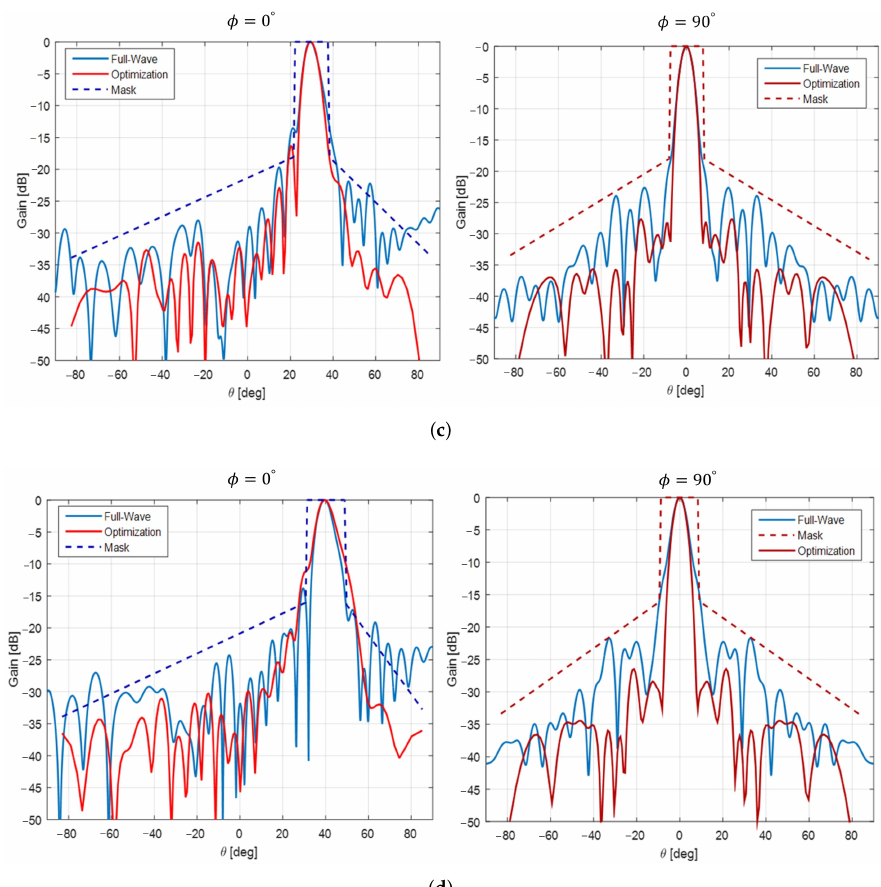
Figure 10. Comparison between radiation patterns of the aperture field method and of the full- wave. Each subfigure represents a different scan angle; the right diagram is the radiation pattern on the E-plane and the left one in the H-planes. ( a ) θ scan = 10 ◦ ; ( b ) θ scan = 20 ◦ ; ( c ) θ scan = 30 ◦ ; ( d ) θ scan = 40 ◦